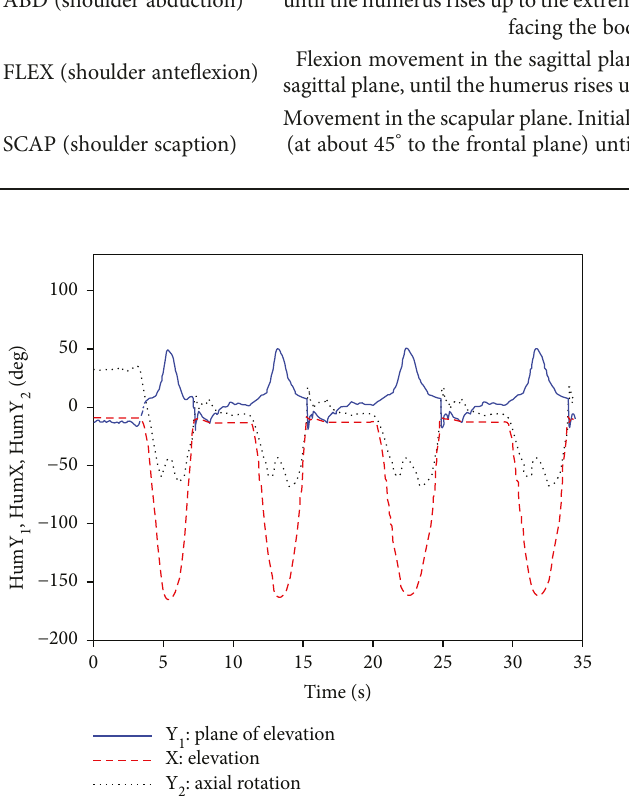
θ 1 and 2 that are adopted to be input